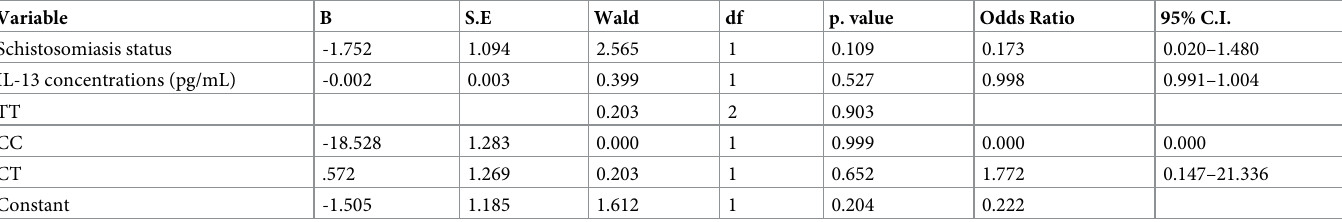
Table 3. Risk of prostate cancer development (PSA > 4 ng/mL and < 4ng/mL) association to schistosomiasis status, IL-13 cytokine concentration and IL-13 rs1800925 variants. Variable B S.E Wald df p. value